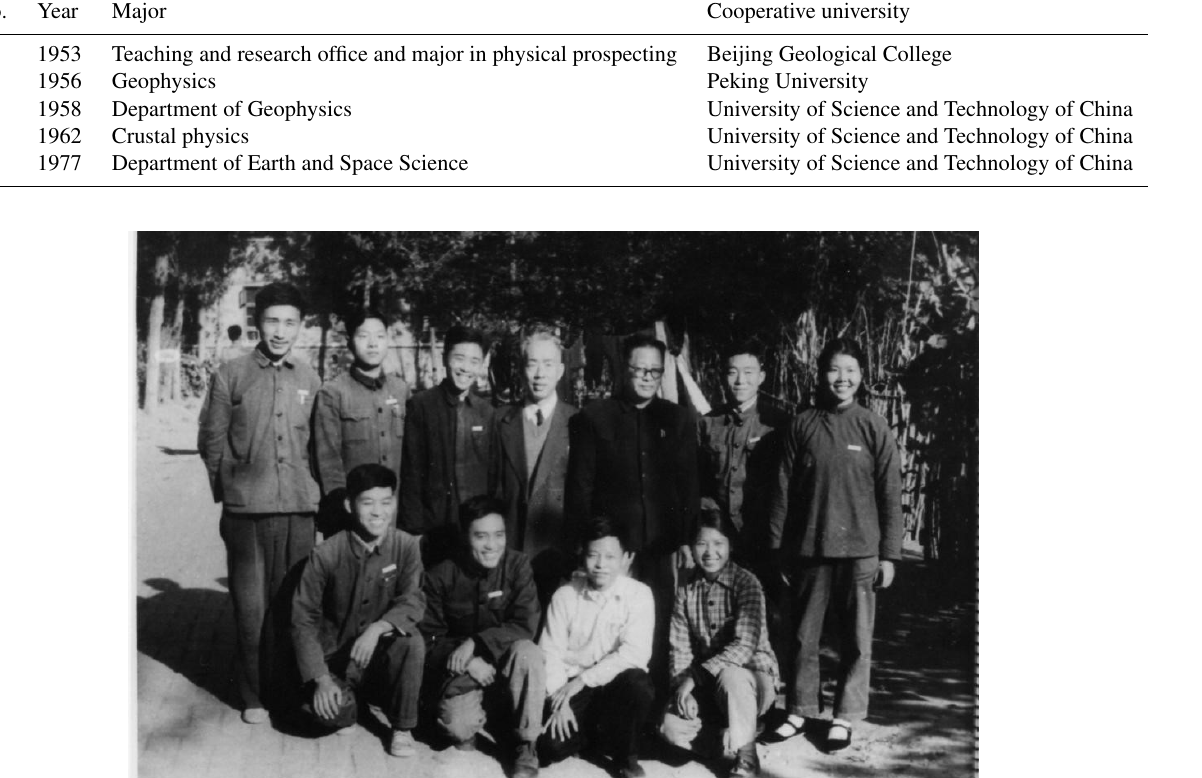
Table 2. Majors and research offices established in higher education institutions with the help of the IGCAS. No.